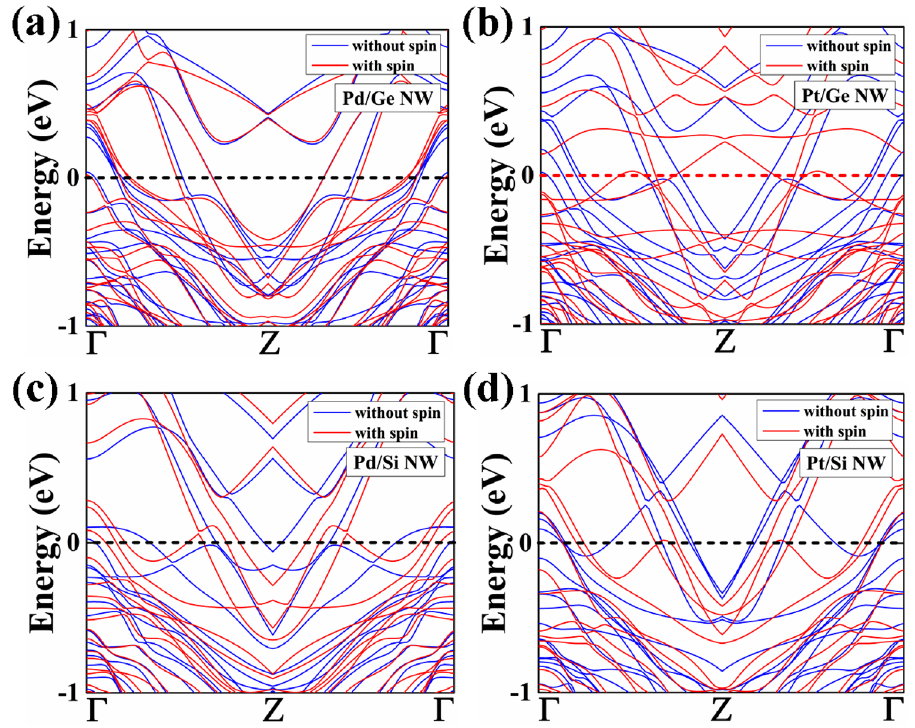
Figure 3. The electronic band structure without spin–orbit interaction and within spin–orbit interaction of ( a ) Pd/Ge, ( b ) Pt/Ge, ( c ) Pd/Si and ( d ) Pt/Si NWs having diameter of 2.2 ~ 2.3 nm (2R) is shown. The Fermi level is set at 0 eV.